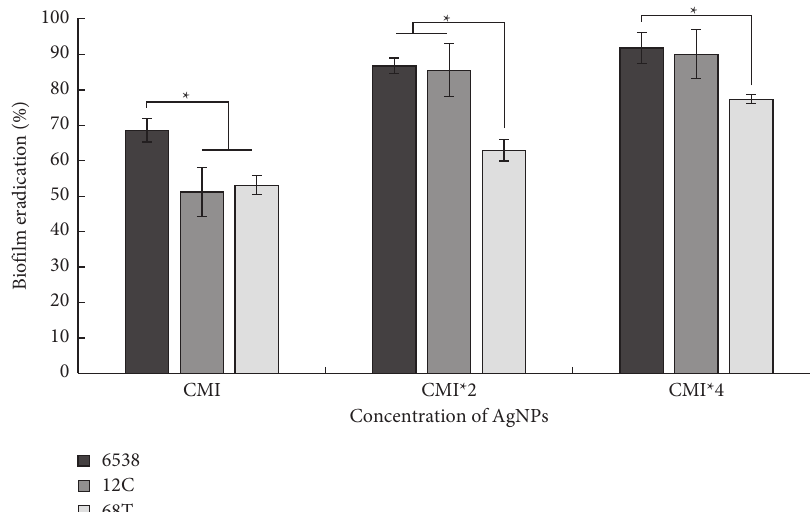
Figure 7: Effects of various concentrations (MIC; MIC ∗ 2; MIC ∗ 4) of dried peel orange AgNPs on the reduction of preformed biofilm of S. aureus strains (6538, 12C, 68T). Shown are the different percentages of biofilm eradication after staining with crystal violet. Error bars represent standard deviations. ∗ Differences were considered significant at p < 0 .